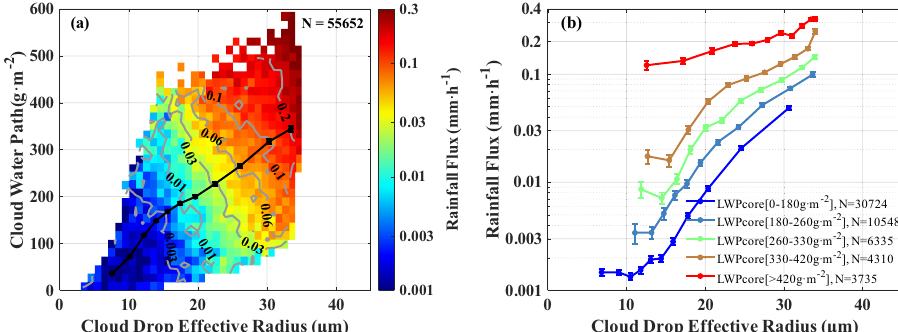
Fig. 1 Combined effects of cloud drop effective radius ( r e ) and cloud liquid water path (LWP) on the rainfall fl ux. a The rainfall fl ux (including both rainfall and non-rainfall cases) from GPM DPR is a function of MSG CLAAS r e and LWP. The color indicates the average rainfall fl ux. The minimum sample size for each bin is 10. The gray lines represent the contours of the rainfall fl ux that are indicated as different colors. The black line connects the dots, which are the averaged LWP at eleven bins of r e , including the 0 – 5%, 5 – 15%, 15 – 25%, 25 – 35%, 35 – 45%, 45 – 55%, 55 – 65%, 65 – 75%, 75 – 85%, 85 – 95% and 95 – 100% quantiles. b The rainfall fl ux (averaging both rainfall and non-rainfall cases) changes with r e at constant LWP bins. Vertical error bars indicate the standard error calculated by the standard deviation divided by the square root of the sample